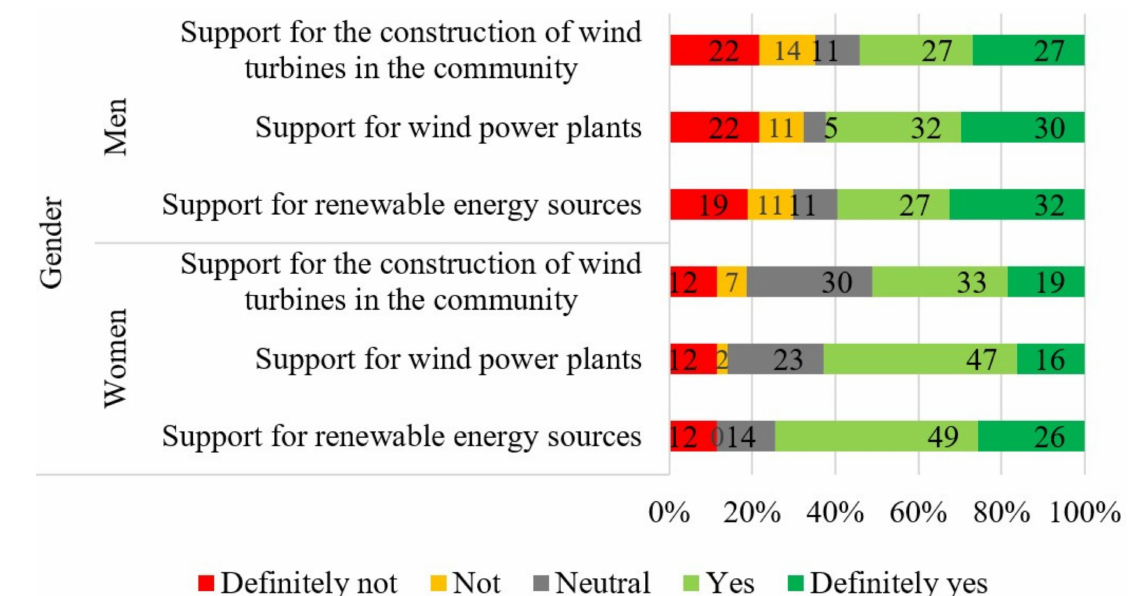
Figure 2. Support for the development of renewable energy technologies, siting of wind farms, construction of a wind farm in the municipality in which the respondents live according to gender of respondents (%). Source: based on own